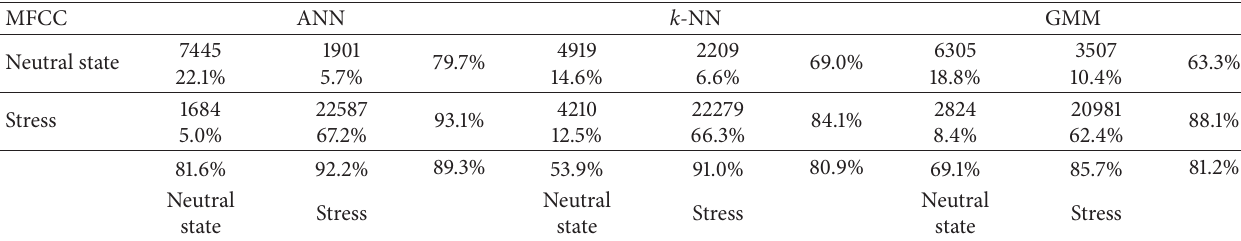
Table 5: Performance results of classifiers for MFCC (dynamic and acceleration coefficients too) features.